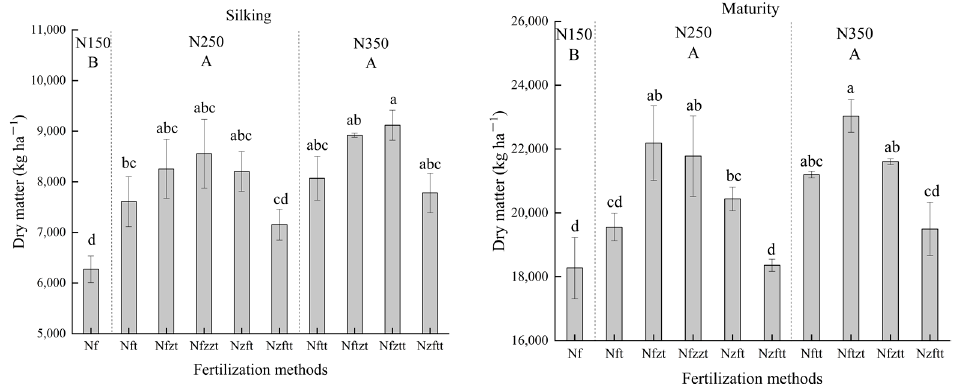
Figure 8. Effects of fertilization methods on dry matter at silking and maturity stages under different nitrogen application rates. N150, N250, and N350 refer to the nitrogen application rate being 150, 250, and 350 kg ha − 1 , respectively. “z” refers to the nitrogen application rate being zero, “f” refers to the nitrogen application rate being 150 kg ha − 1 , “t” refers to the nitrogen application rate being 100 kg ha − 1 , e.g., Nf refers to nitrogen application rate being 150 kg ha − 1 at sowing stage; Nfzt refers to nitrogen application rate being 150, 0, and 100 kg ha − 1 at sowing, 6-leaf, and 12-leaf stages, respectively; Nzftt refers to the nitrogen application rate being 0, 150, 100, and 100 kg ha − 1 at sowing, 6-leaf, 12-leaf, and silking stages, respectively. The data were averaged over 2018 and 2019. Capital letters indicate a significant difference at the p < 0.05 level under different nitrogen application rates.